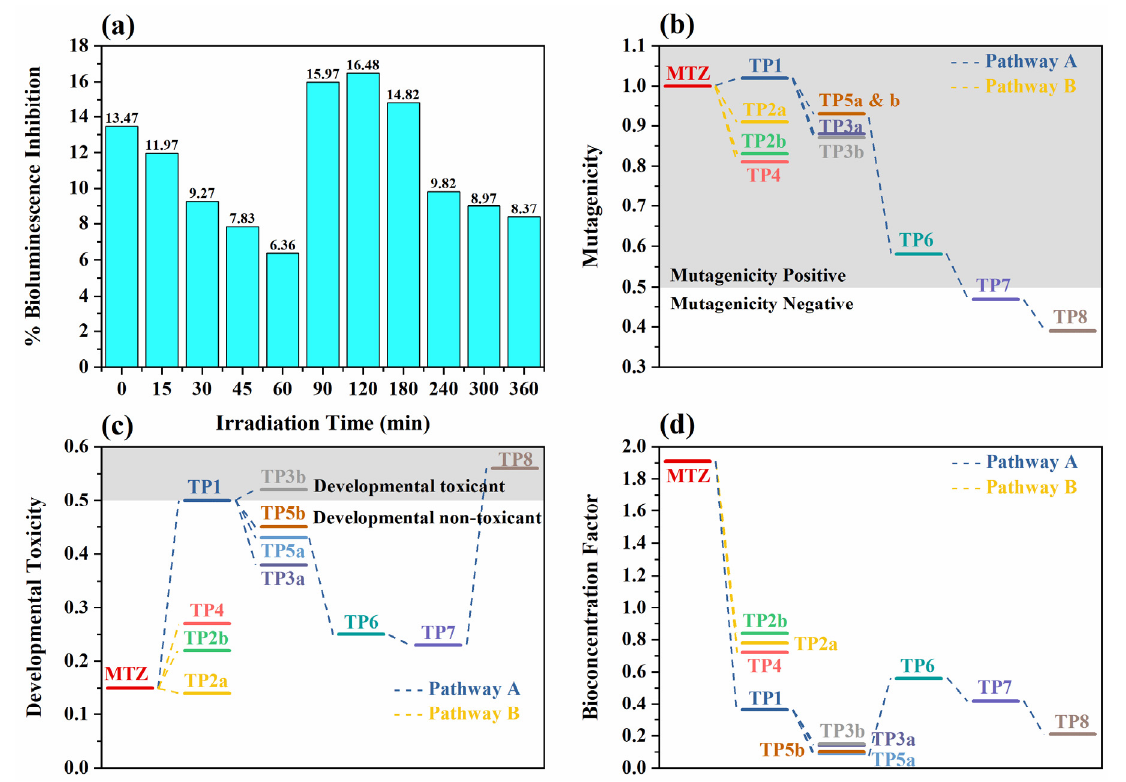
Figure 3. ( a ) % Bioluminescence inhibition of Vibrio Fischeri vs. irradiation time under lab-scale conditions and predicted values (in silico) for ( b ) mutagenicity, ( c ) developmental toxicity and ( d ) bioconcentration factor of MTZ and its identified TPs.